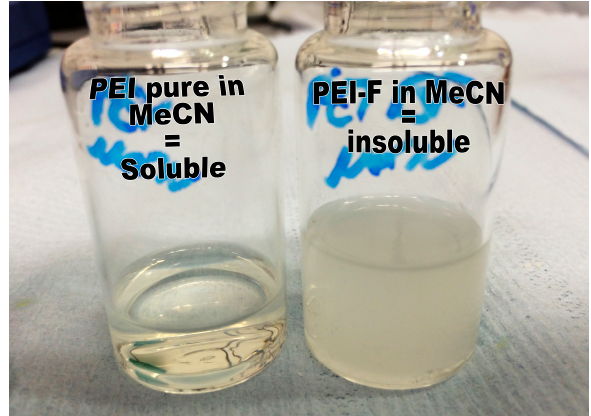
Figure 2. Change in physical properties of NH 4 F after reaction with PEI.